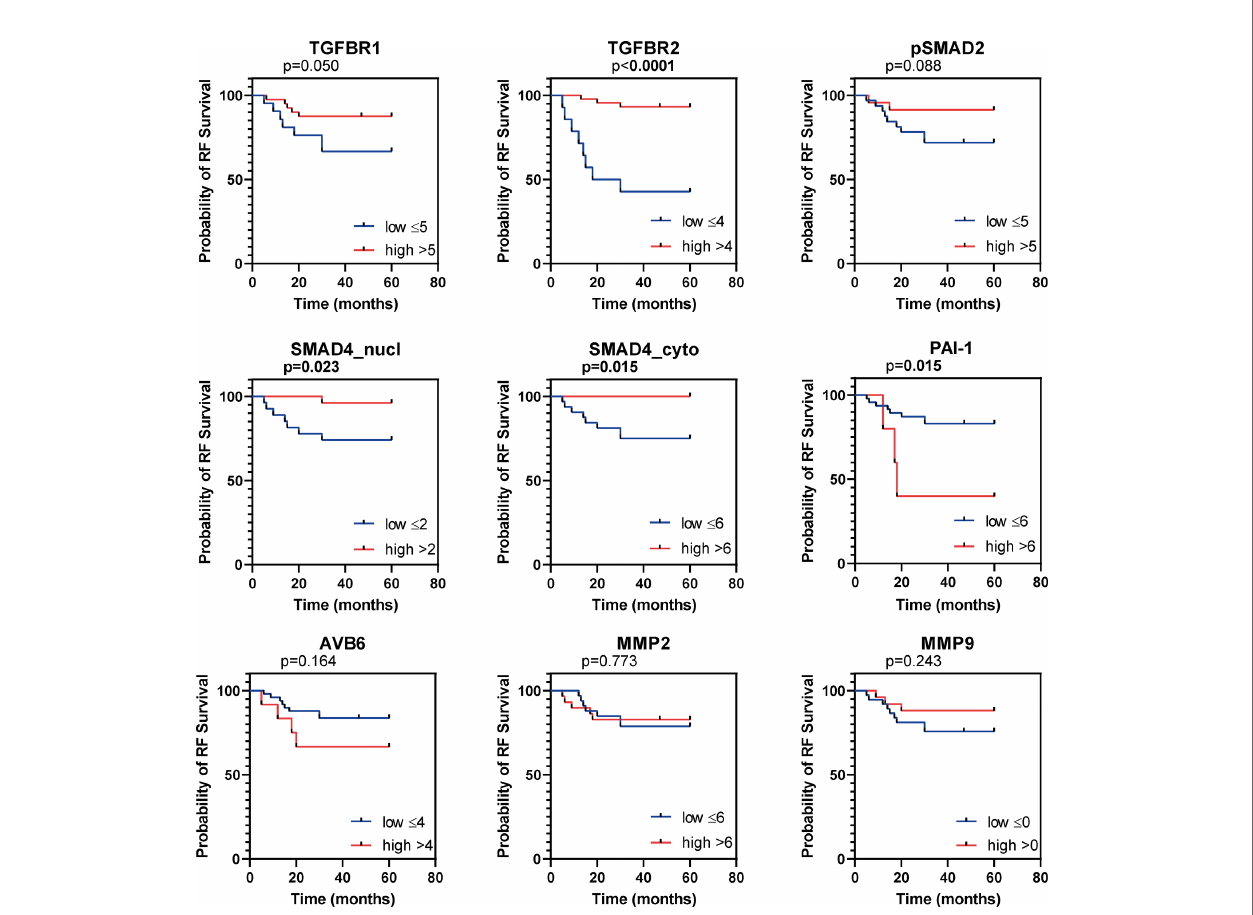
FIGURE 3 | Kaplan Meier curves for recurrence free survival (RFS). Kaplan Meier curves for RFS of the institutional AC cohort, dichotomized as indicated by the numbers in the legend. P values based on log-rank test, bold indicates signi fi cance (p ≤